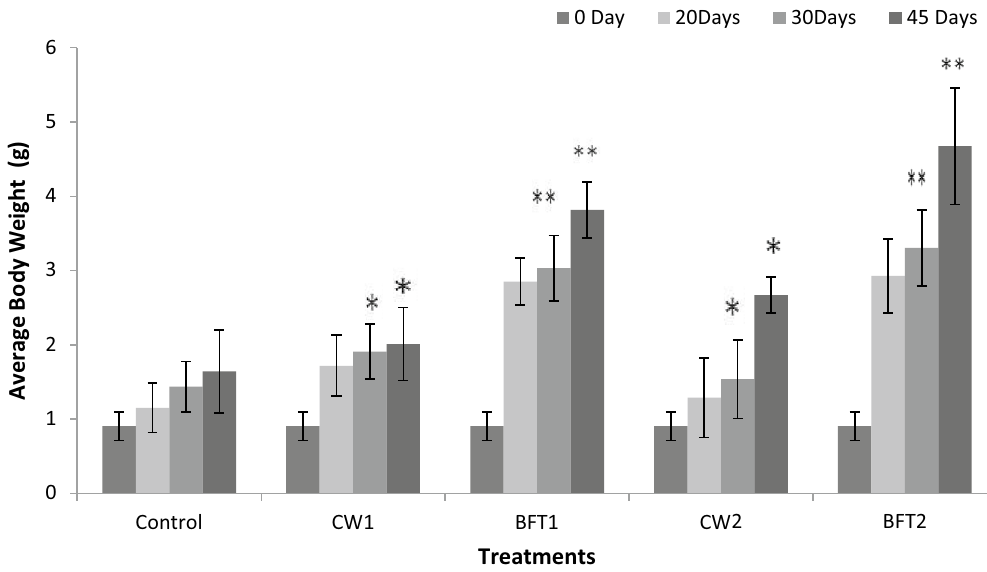
Figure 1. Growth performance of P. indicus reared in different probiotic and biofloc systems and error bar showing standard deviation of three replicates. Significance between different groups ( P < 0.05) marked with asterisk